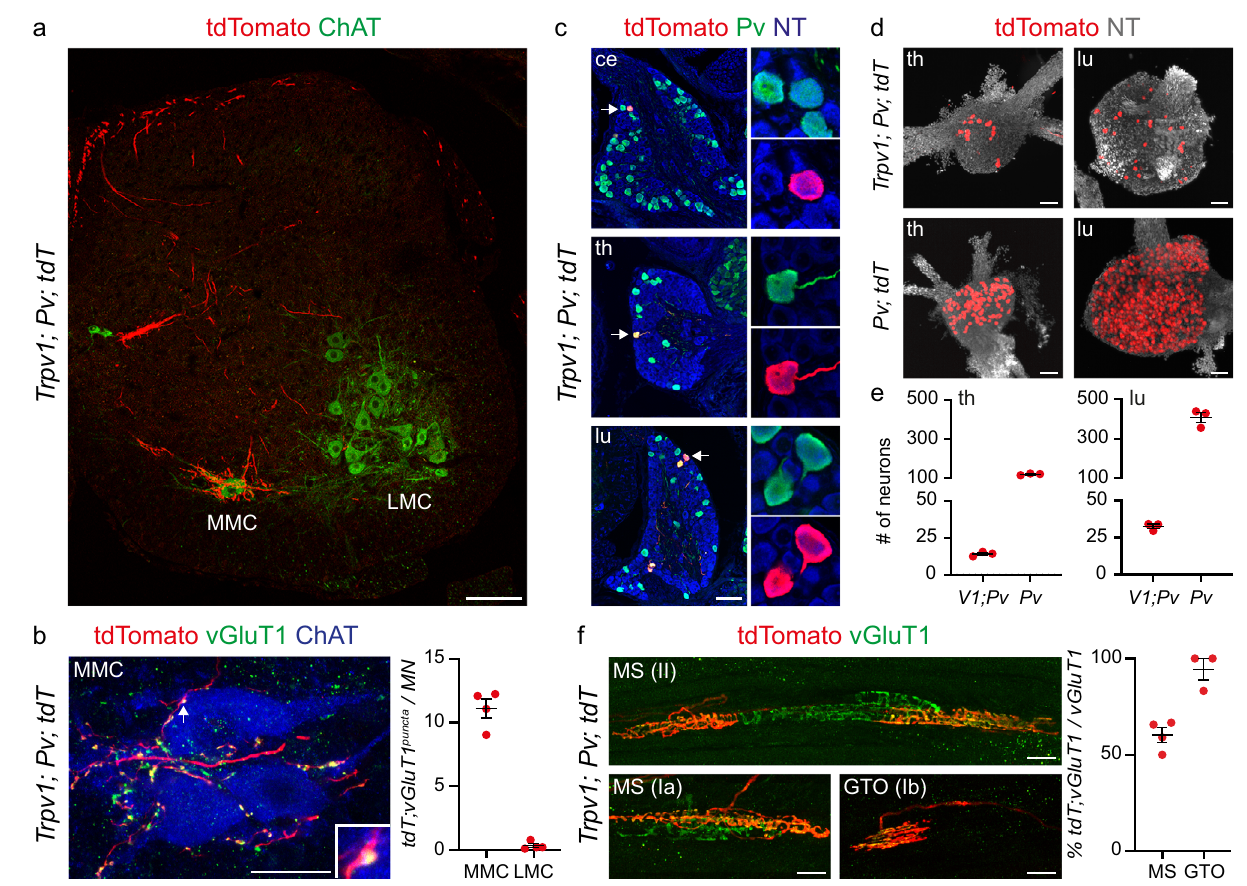
Fig. 2 | Genetic targeting of proprioceptors innervating back muscles. a RepresentativeimageoftdTomato + afferentsinalumbarspinalcordsectionfrom p7 Trpv1 Cre ; Pv Flp ; Ai65 mice. MMC, median motor column; LMC, lateral motor col- umn. Scale bar: 100 µ m. b Representative image (MMC, left) and quanti fi cation (right) of tdTomato + ; vGluT1 + presynaptic puncta juxtaposed to MMC or LMC neurons cell bodies and proximal dendrites of p7 Trpv1 Cre ; Pv Flp ; Ai65 mice (mean±SEM, n =4 animals). Scale bar: 25 µ m. c Representative images of cervical, thoracic, and lumbarDRG sections showing tdTomato + ; Pv + neurons in p7 Trpv1 Cre ; Pv Flp ; Ai65 mice. Scale bar: 100 µ m. d Whole mount preparations of thoracic (left)